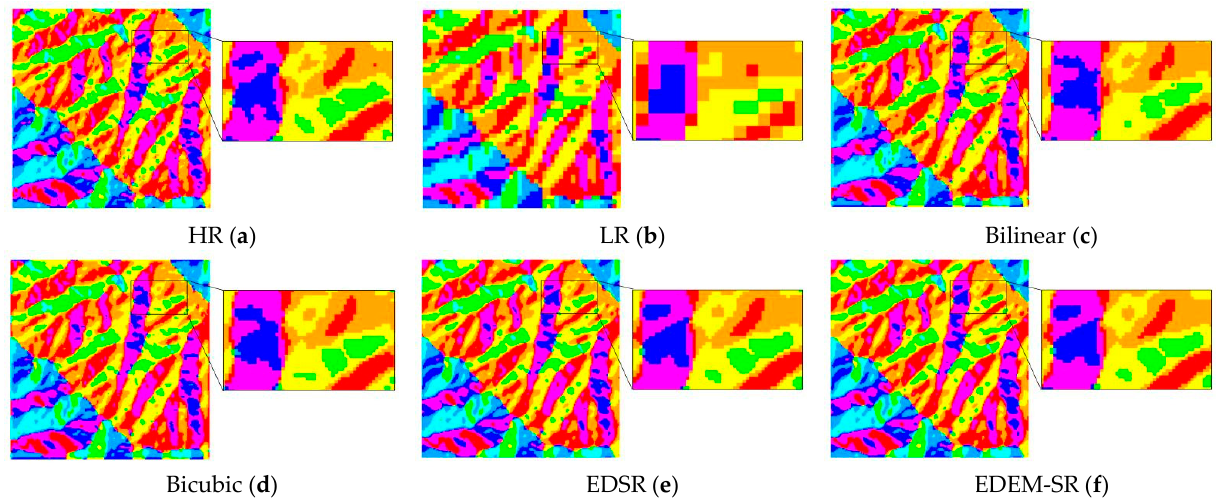
Figure 8. Example slope map visualizations with an up-scaling factor of 4.